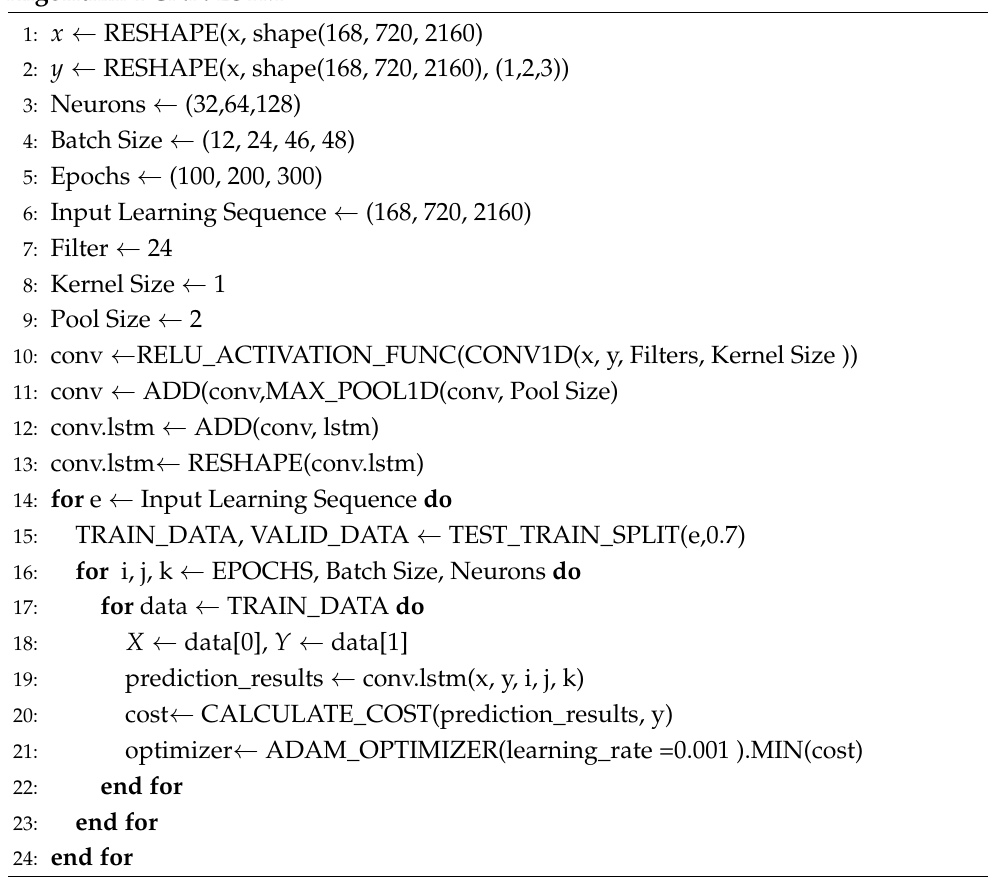
Algorithm 4 CNN LSTM